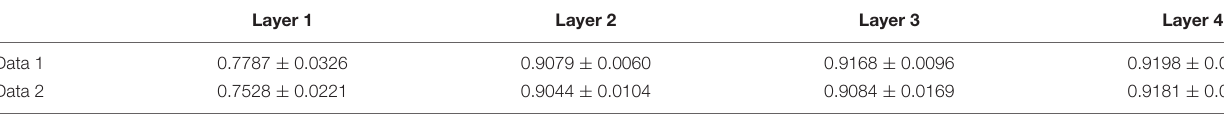
TABLE 2 | The classification accuracies in different layers of the DCAE model (mean ± std).